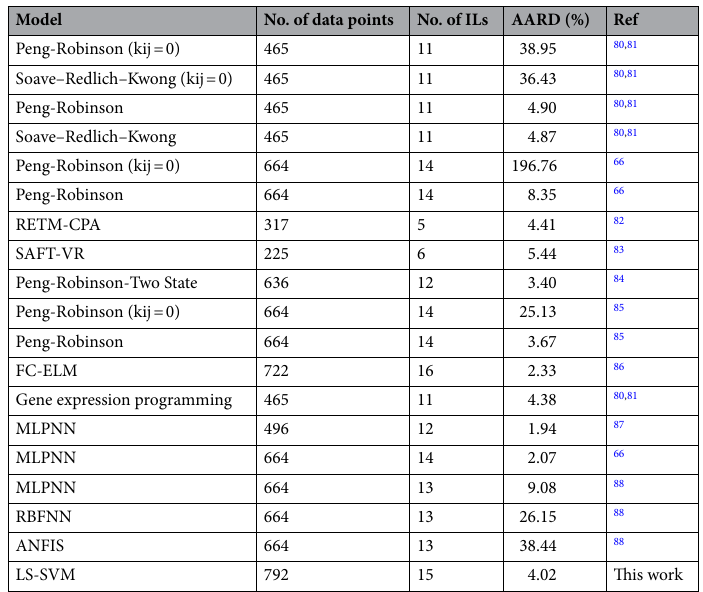
Table 5. Comparison between the developed LS-SVM model and the available approaches in the literature for estimating H 2 S solubility in ILs based on